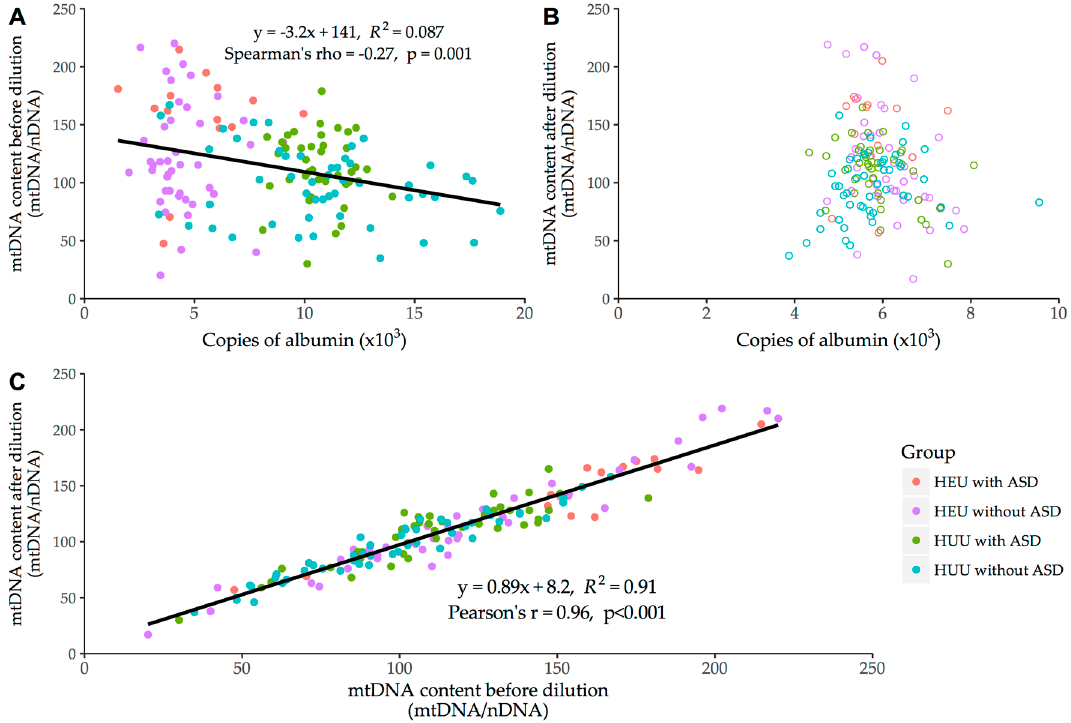
Figure 4. Correlation of mtDNA content and albumin copy number before (panel A ) and after dilution to a common albumin concentration (panel B ). Linear correlation of mtDNA content measurements before and after systematic dilution (panel C ).